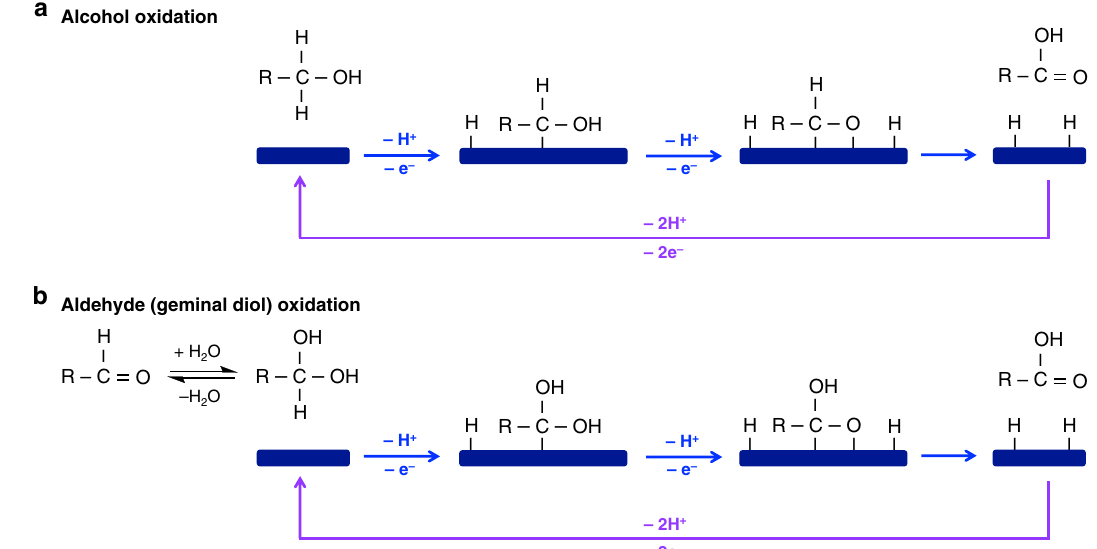
Fig. 2 Schematic illustration of proposed alcohol and aldehyde oxidation mechnaisms on MOOH. The – e − and – H + in blue indicate those transferred from the organic molecule to MOOH, while the – e − and – H + in purple indicate those transferred from reduced MOOH ( = M(OH) 2 ) to the back contact and to a base in solution,